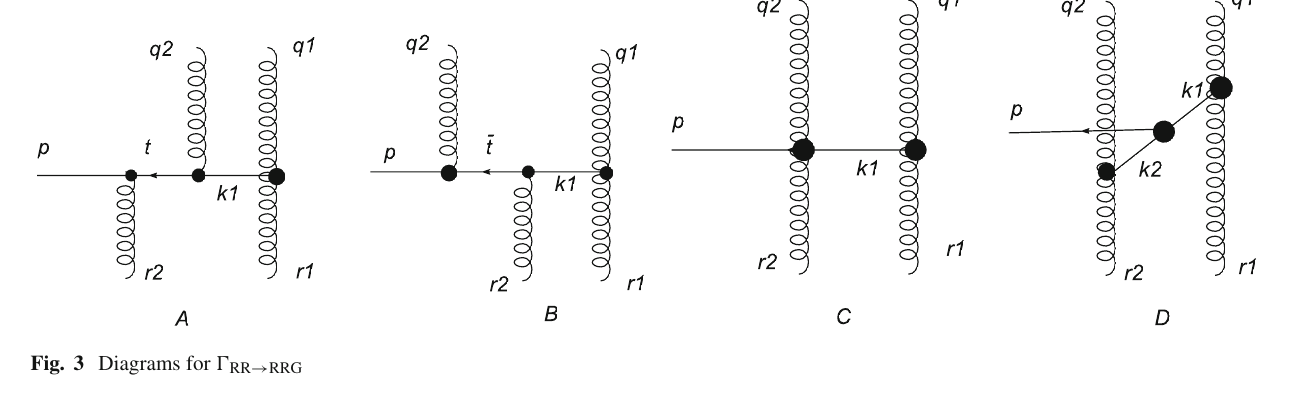
Fig. 3 Diagrams for (cid:2) RR → RRG + permutations of r